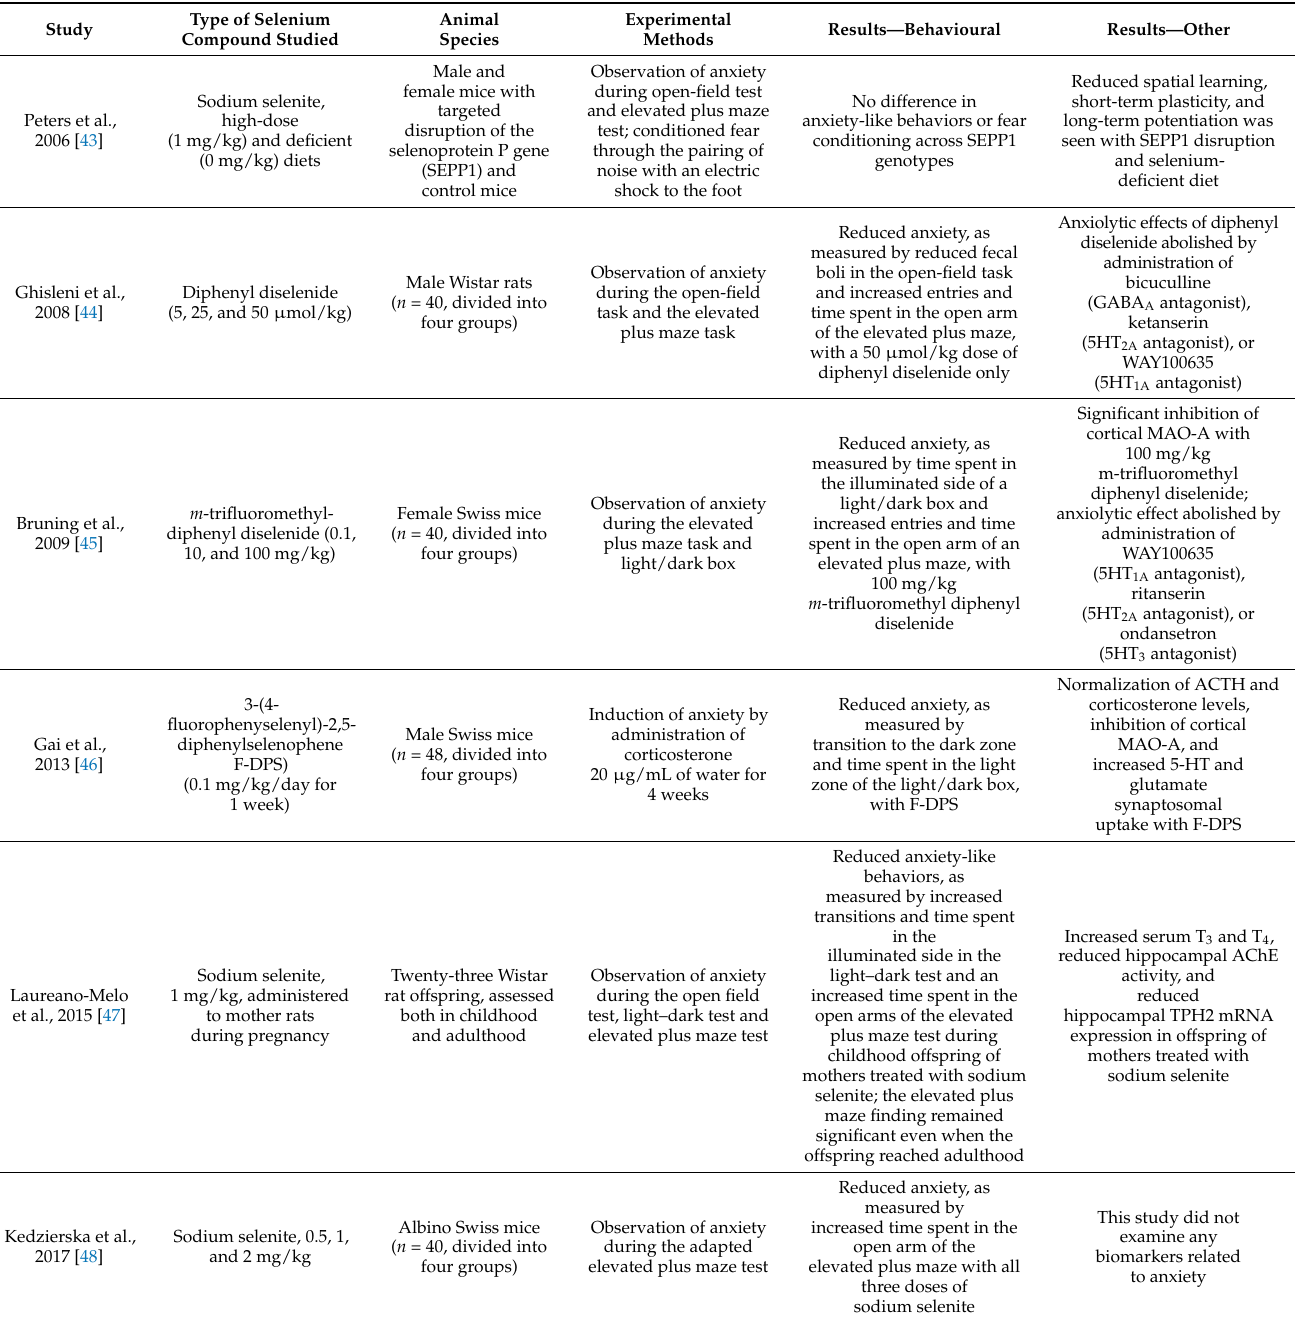
Table 1. Animal studies of selenium, selenoproteins, and selenium-containing compounds in relation to models of